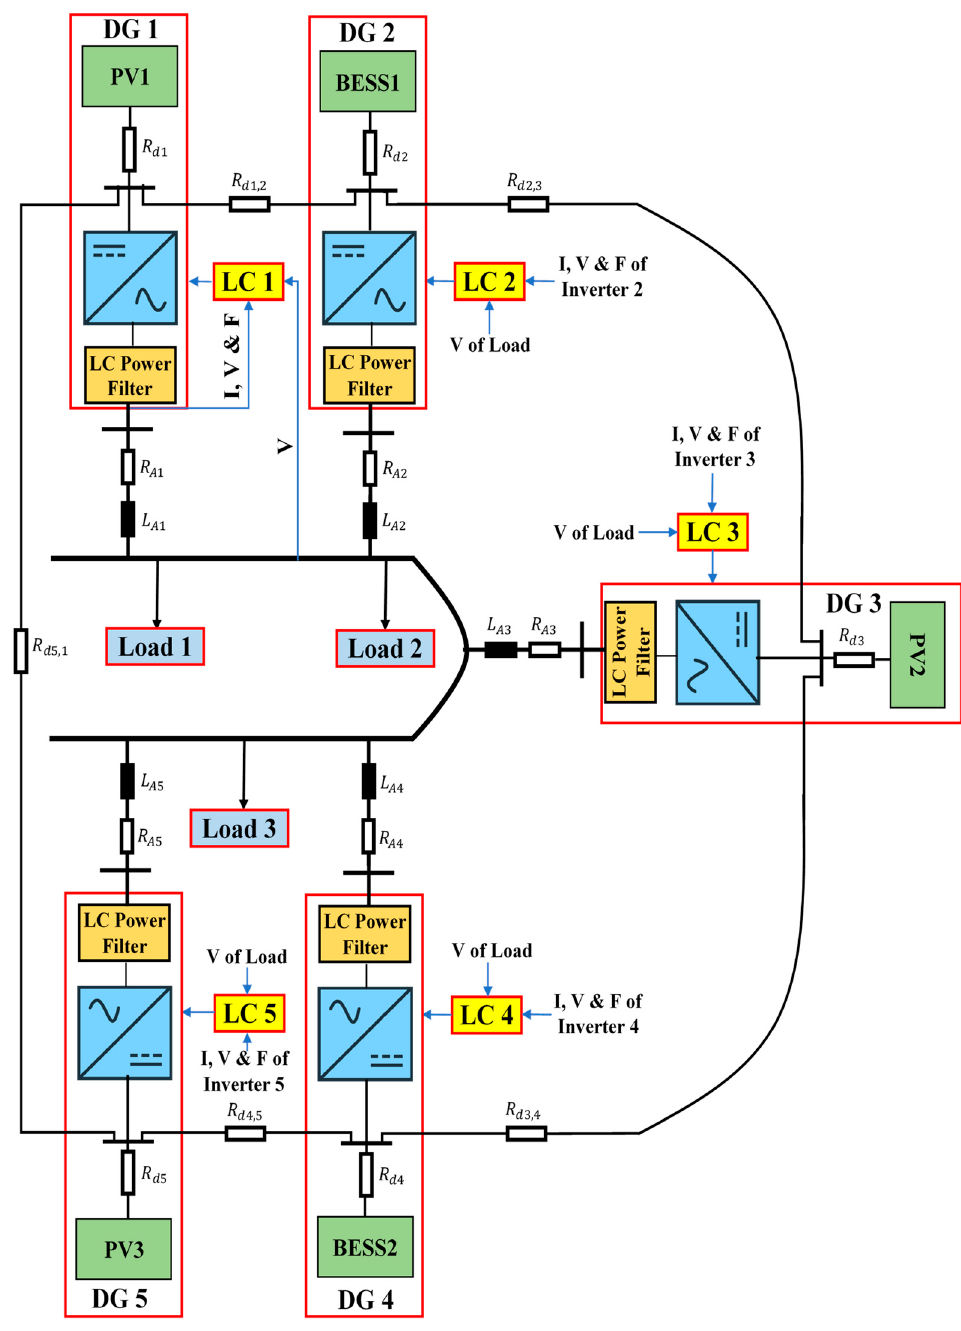
Figure 2. The adopted islanded MG. Table 1. The MG line